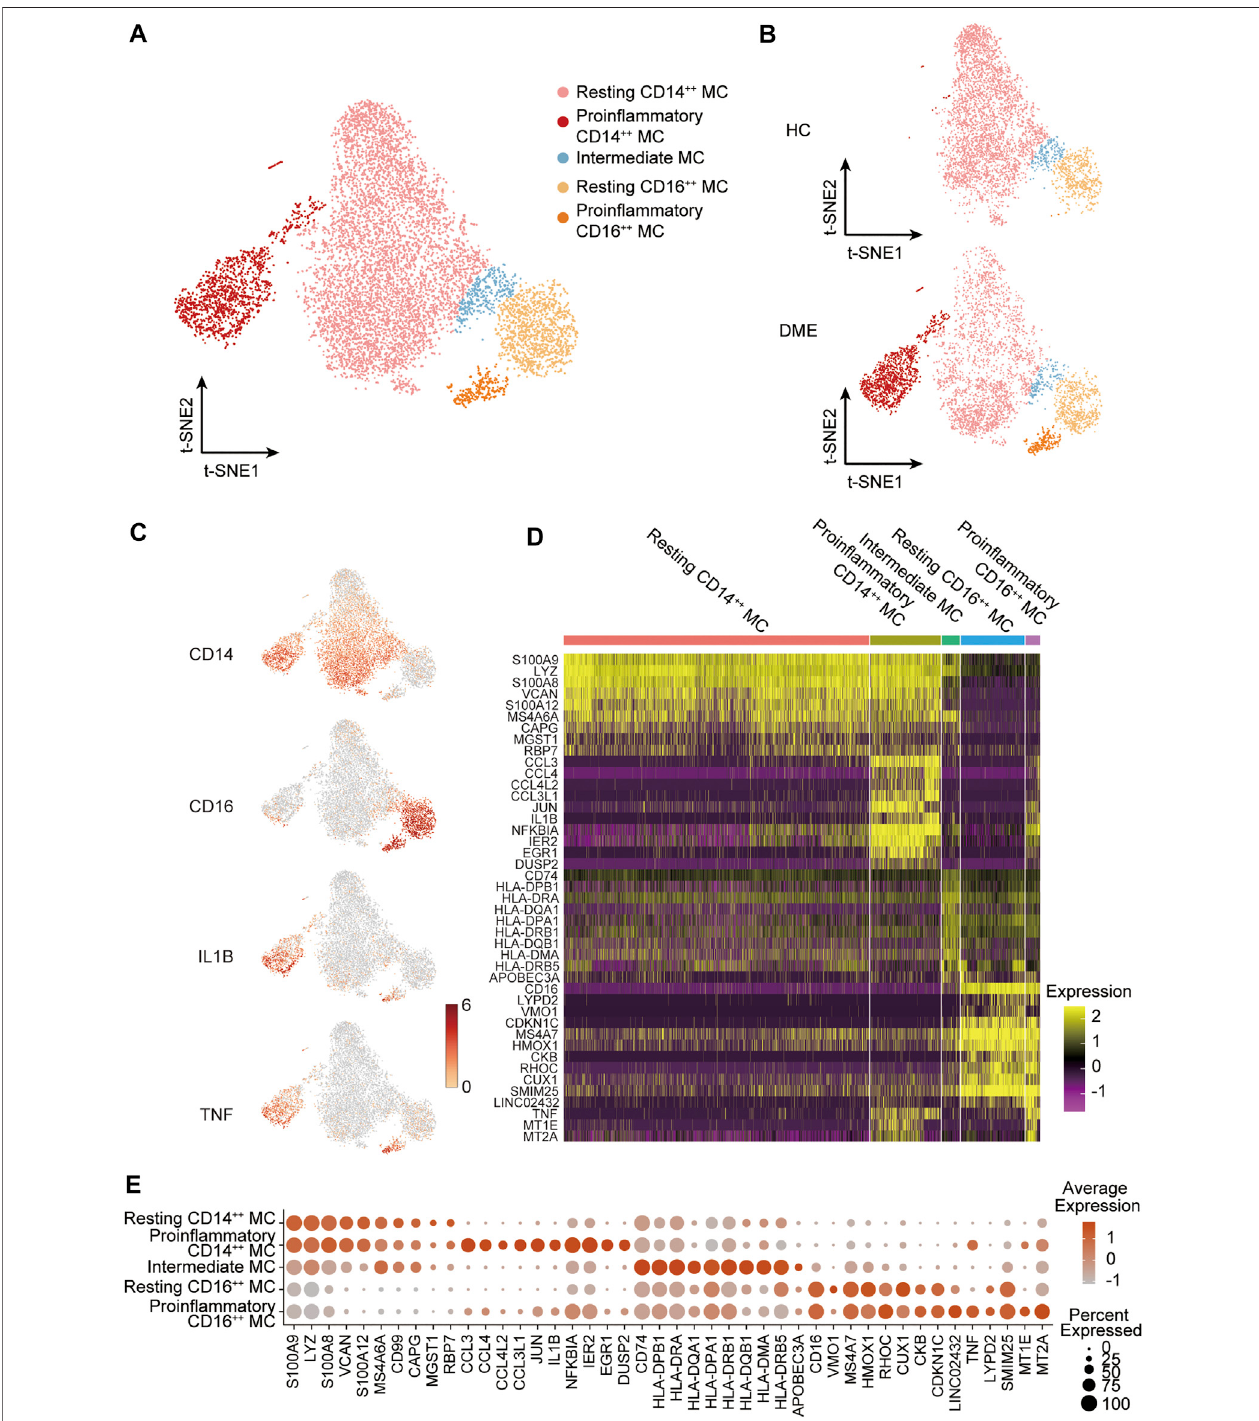
FIGURE 3 | MC subset classification and characterization in DME patients. (A) T-sne plot of major MC subsets. Cell subtypes are labeled with colors as indicated. (B) T-sne plot of major MC subsets in HC and DME, respectively. Cell subtypes are labeled with colors as indicated. (C) The feature plot showing the expression of canonical lineage markers in all clusters. (D) The heatmap showing expression of top 10 marker genes in all MC subsets. (E) The dot plot showing expression of top 10 marker genes in all MC subsets.